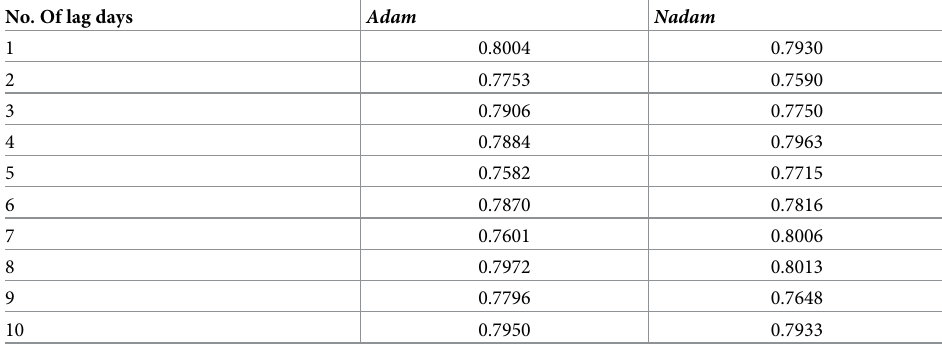
Table 5. R-squared values corresponding to lookback periods for Adam and Nadam optimizers. No. Of lag days Adam Nadam